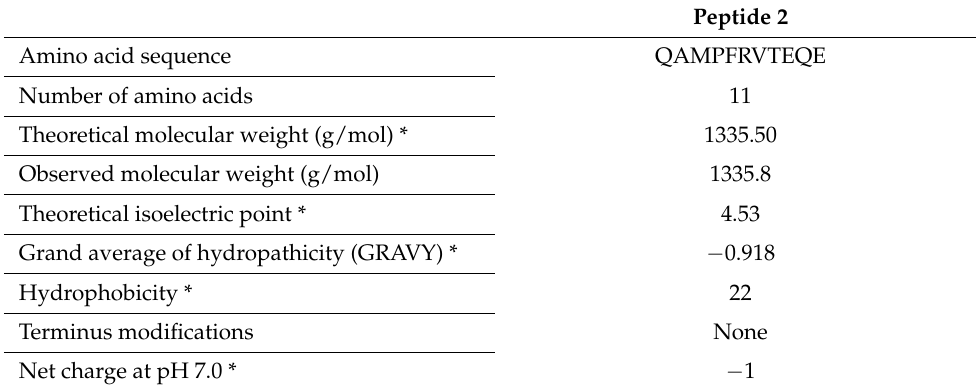
Table 1. Peptide 2